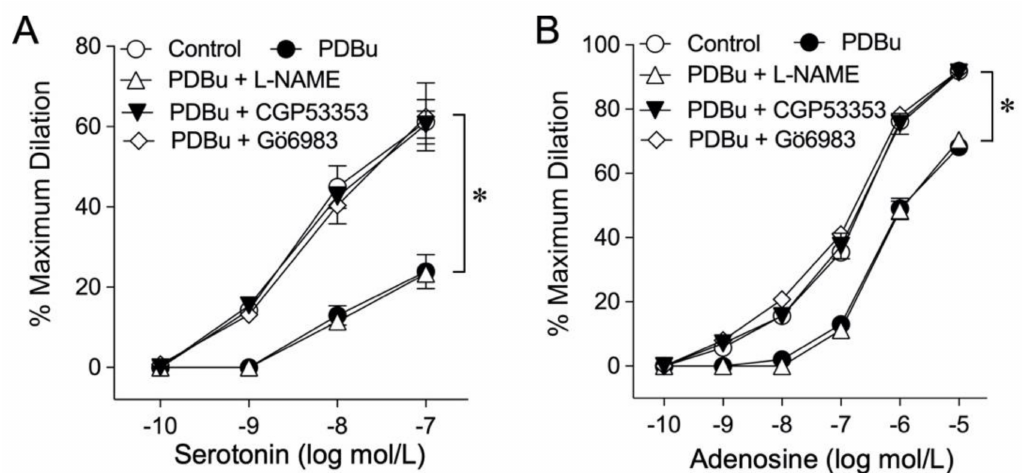
Figure 2. Impact of PKC activation on NO-mediated vasodilations to serotonin and adenosine. Vasodilations in response to serotonin ( A ) and adenosine ( B ) were inhibited by pre-treating the vessels with 1 nmol/L PDBu for 60 min ( n = 6). The pan-PKC inhibitor Gö6983 (1 µ mol/L, n = 5) and PKC β 2 inhibitor CGP53353 (0.3 µ mol/L, n = 5) prevented the PDBu-induced impairment of endothelium-dependent vasodilations. NOS inhibitor L-NAME (10 µ mol/L, n = 4) did not alter the inhibitory effect of PDBu. * p < 0.05 vs. the control, two-way repeated measures ANOVA with Tukey’s multiple comparison